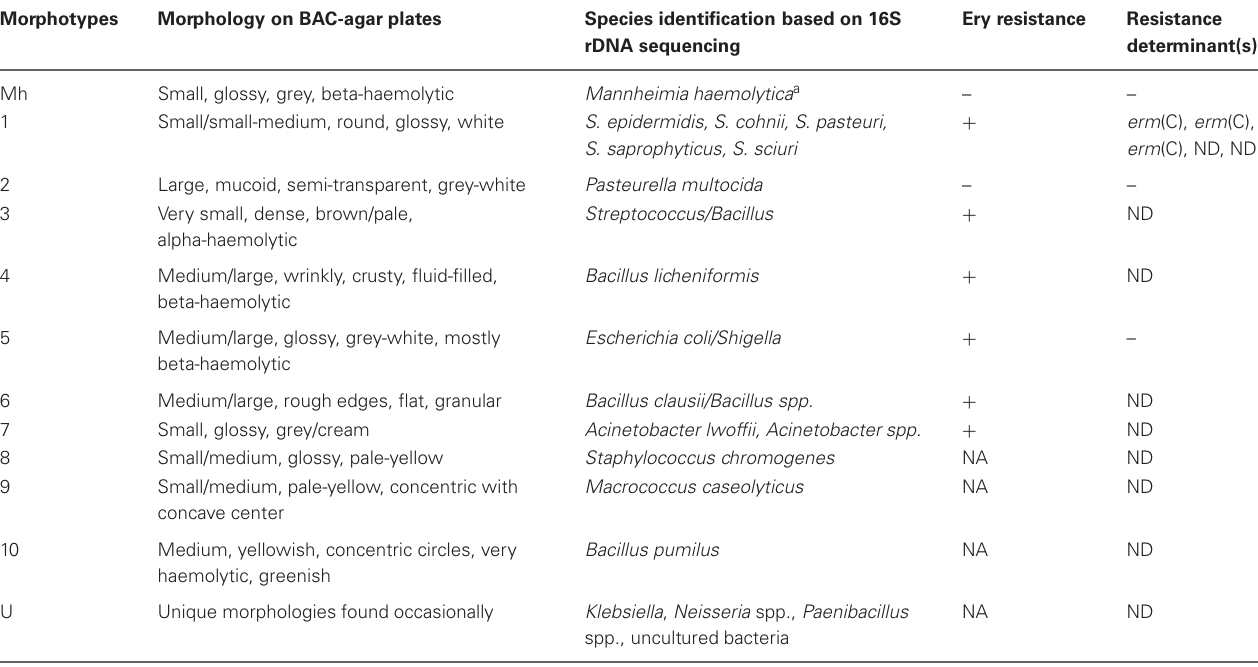
Table 2 | Bacteria co-isolated with M. haemolytica.